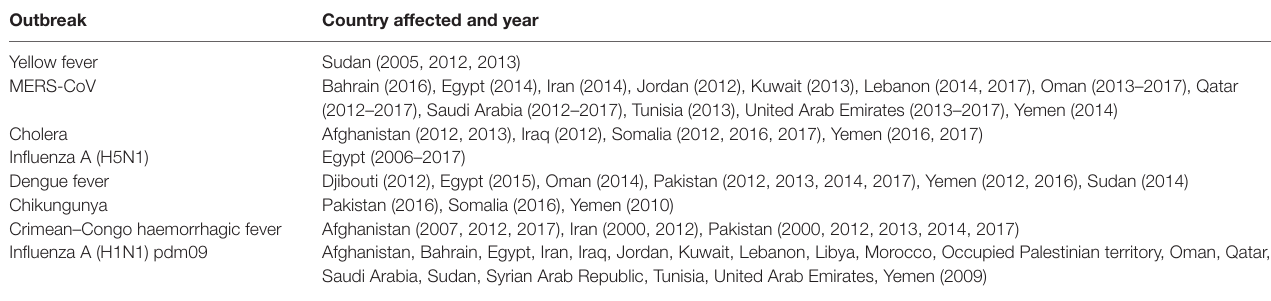
TABLe 1 | Summary of recent infectious disease outbreaks in Eastern Mediterranean Region. Outbreak Country affected and